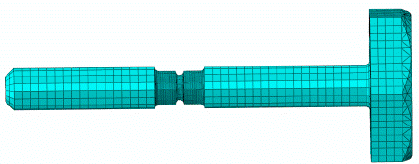
Figure 3. Schematic of notch bolt meshing.